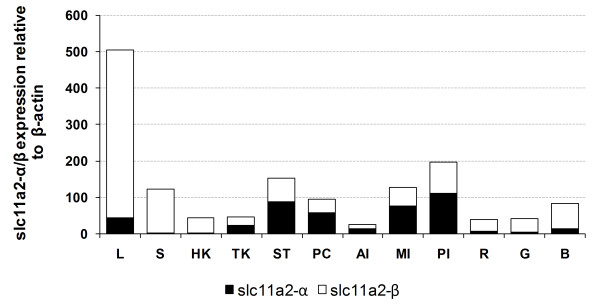
Constitutive expression of slc11a2-α and slc11a2-β. Constitutive expression was measured in several sea bass organs by real-time PCR. Each sample was normalized to β-actin, calculated by the comparative CT method (2-ΔΔCT). L - liver; S -spleen; HK - head kidney; TK - trunk kidney; ST - stomach; PC - pyloric ceca; AI - anterior intestine; MI - mid intestine; PI - posterior intestine; R - rectum; G - gill; B - brain.